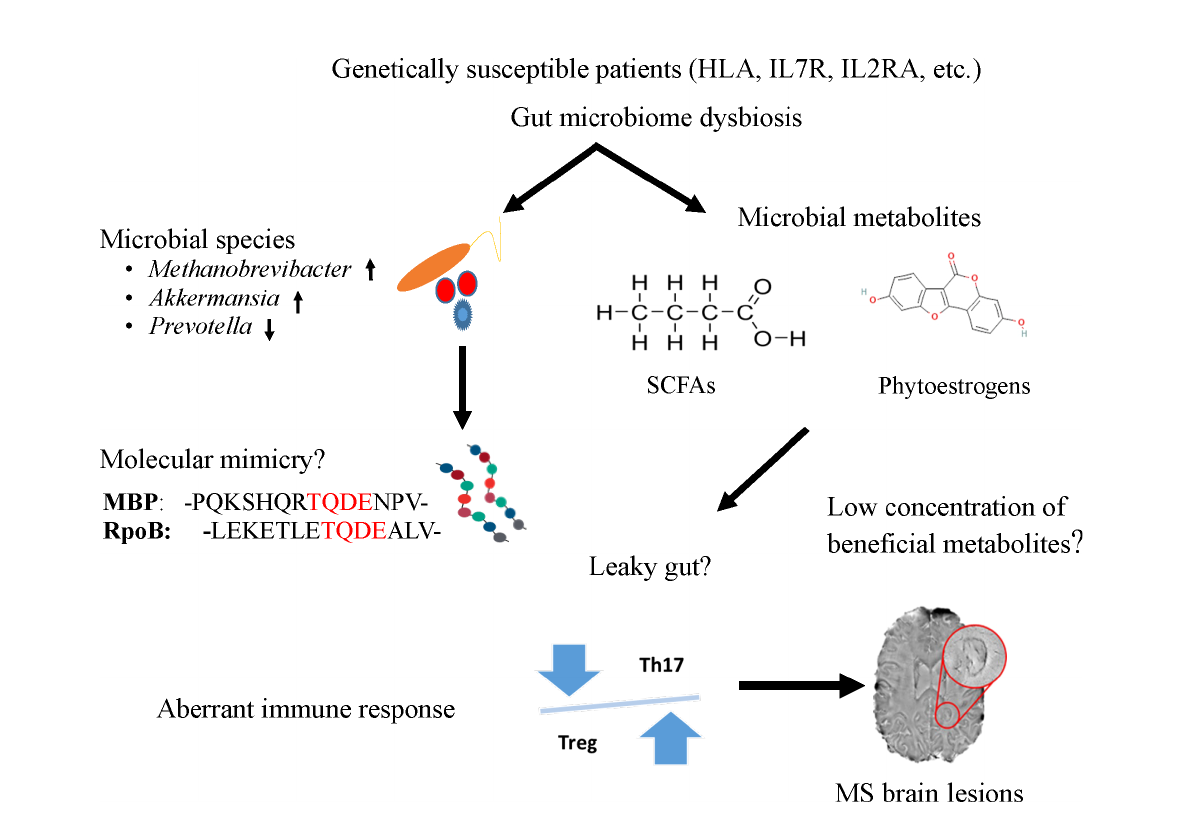
FIGURE 1 A potential mechanism to link the role of gut microbiome to trigger and maintain MS symptoms in genetically susceptible patients. Speci fi c microbes (e.g., Methanobrevibacter and Akkermansia), microbial peptides [RNA polymerase B (103)], or metabolites (short chain fatty acids and phytoestrogens) from the gut could enter the circulatory system due to leaky gut and induce aberrant immune response, particularly the imbalance of Th and Treg cells. The T cells imbalance where Th17 cells outnumber Tregs impairing immune tolerance and subsequently lead to in fl ammation and MS lesions in the